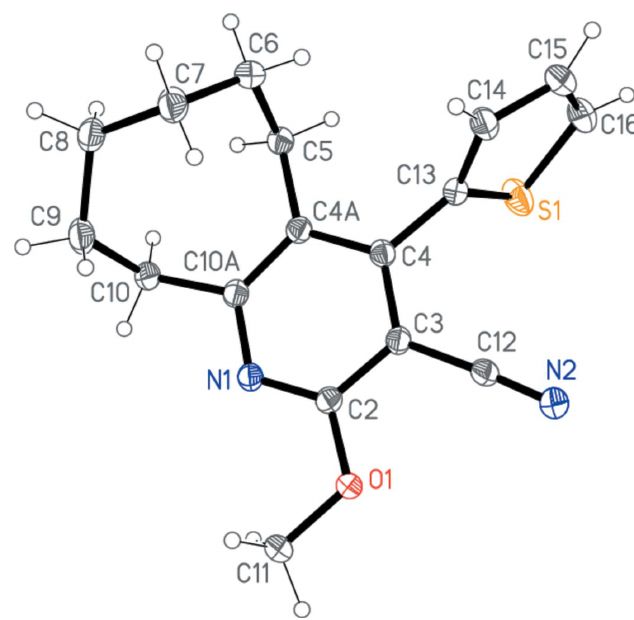
Figure 3 The molecule of 1c in the crystal. Ellipsoids represent 50% probability levels. The minor positions [occupation factor 0.101 (3)] of the disordered atoms C7 and C8 are omitted.